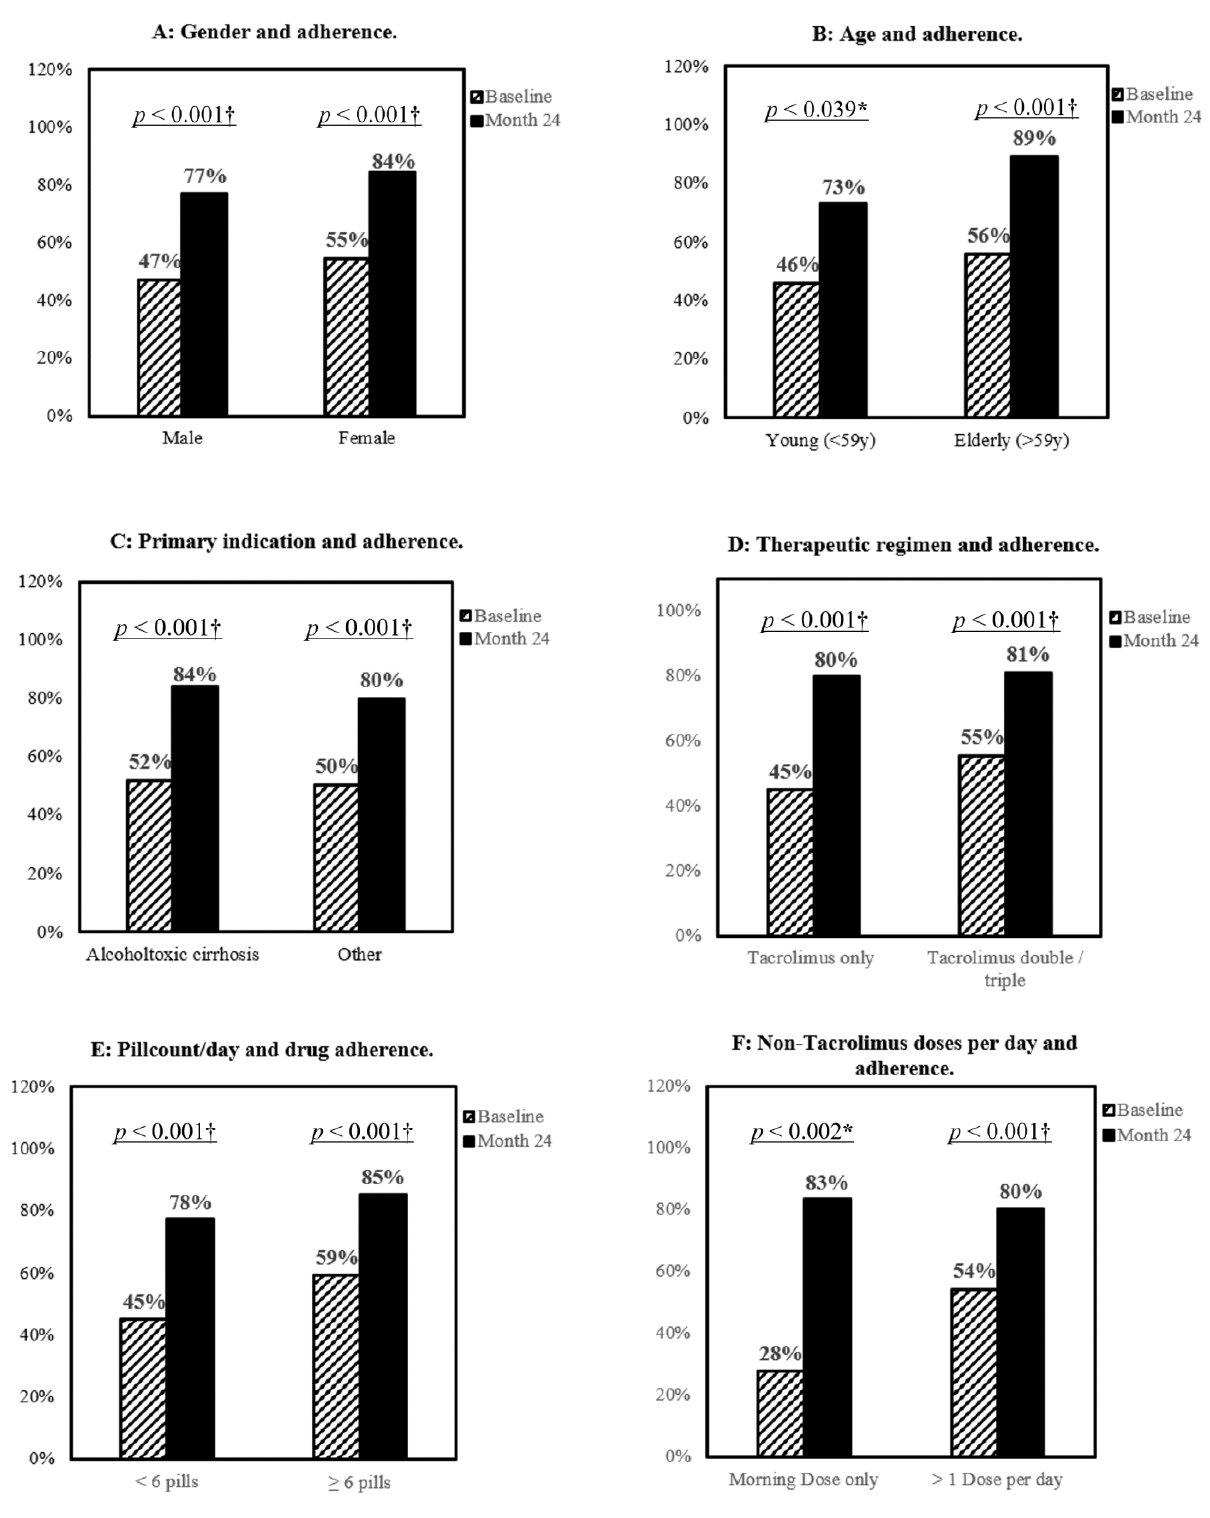
Figure 3. Evolution of overall adherence split by gender ( A ), age ( B ), primary indication ( C ), and therapeutic complexity ( D – F ), n = 134. * p = < 0.05, † p < 0.001, McNemar’s test. Interestingly, patients with Tac-based monotherapy regimen reported a 10% lower adherence at baseline than patients with more complex therapy regimens. After 24 months, both patients under Tac-based monotherapy and under a Tac-based dual or triple immuno- suppressive regimen achieved an improvement in adherence to 80% and 81%,